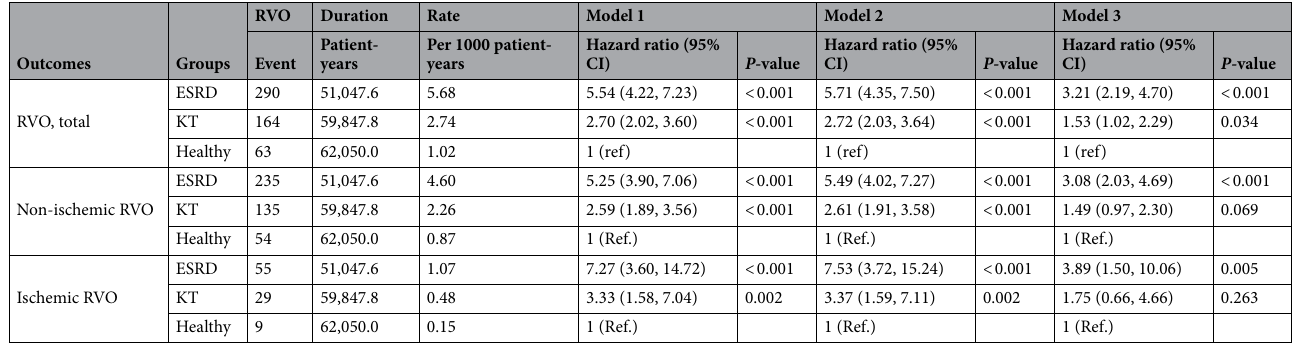
Table 2. Incidence of RVO in ESRD group, KT group and healthy controls. Analysis was performed using Cox regression. Model 1: not adjusted; Model 2: adjusted with age, sex; Model 3: adjusted with age, sex, diabetes